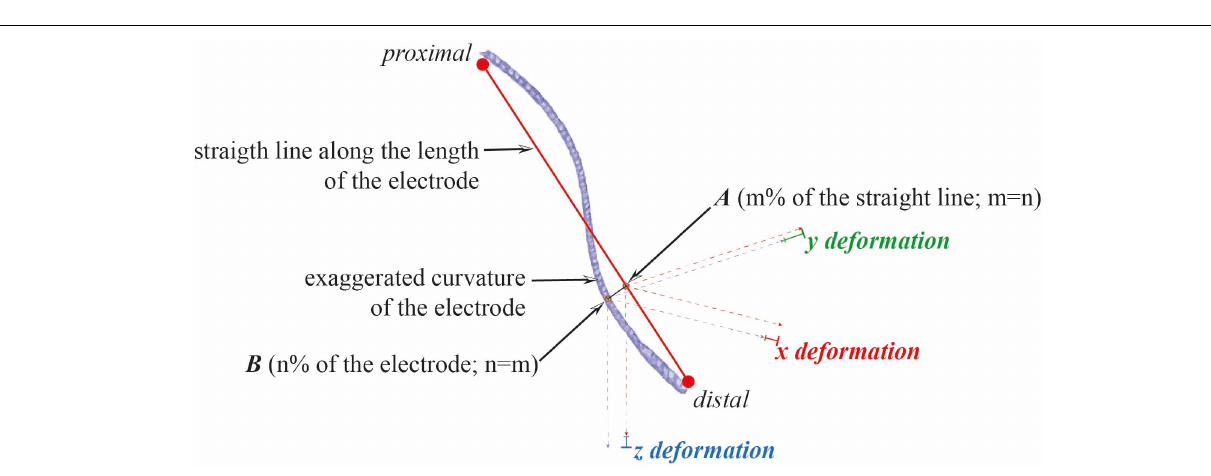
FIGURE 7 | Surgical-related inaccuracy. The Euclidian distance (red) was calculated between the reference point (black) of the selected contact and the selected point (white) along the selected tract.